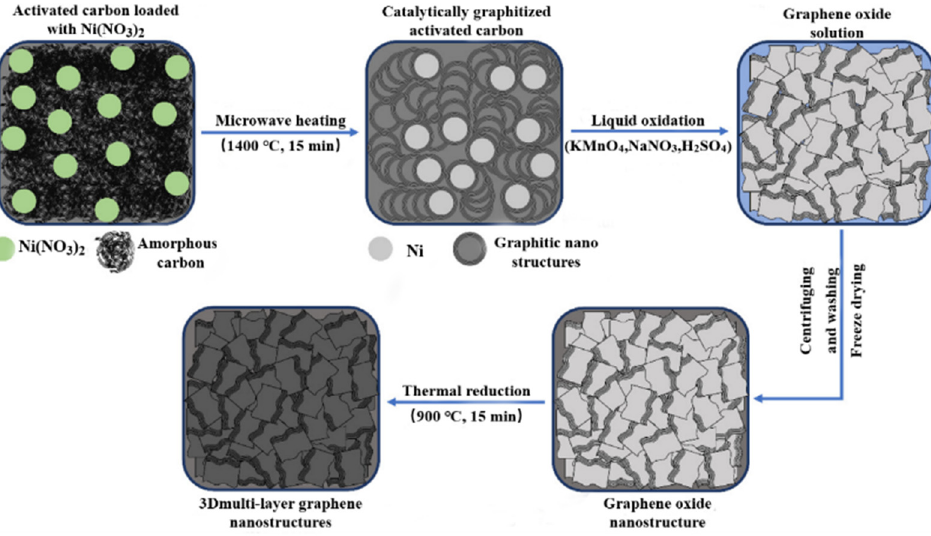
Figure 12. Schematic diagram of the synthesis process of 3DMGs. Reproduced with permission from SalmanKhoshk Rish, Novel composite nano-materials with 3D multilayer-graphene structures from biomass-based activated-carbon for ultrahigh Li-ion battery performance; published by Elsevier, 2021 [111].